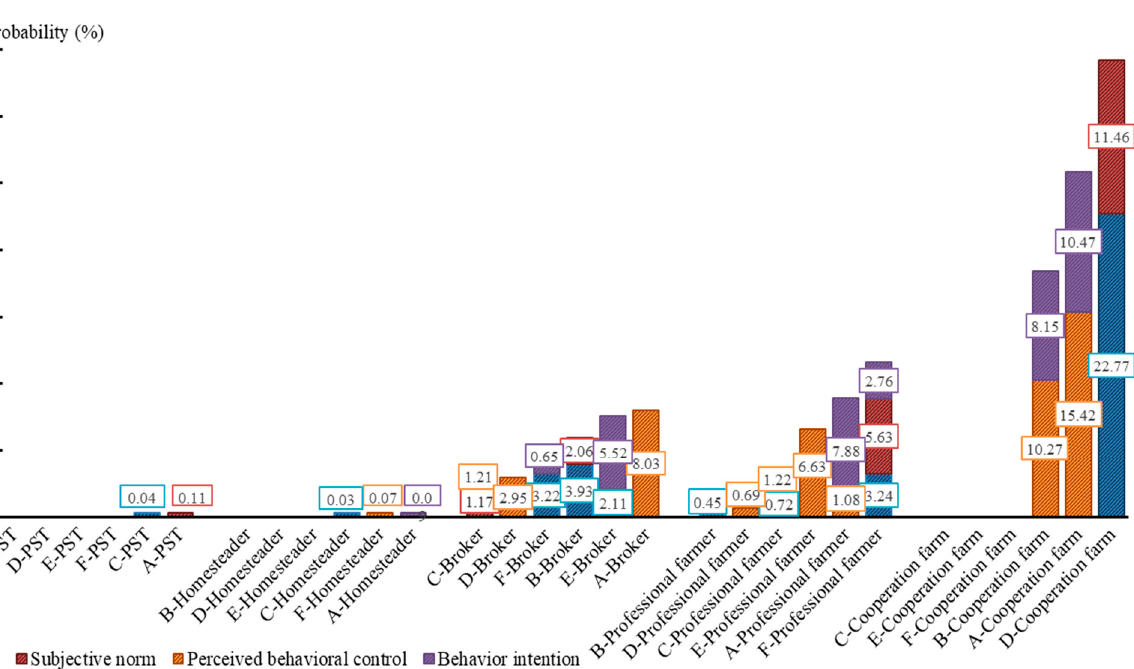
Figure 3. The effect comparison of each factor in the TPB for different potential farmer statuses for different contract types. Note: “A” designates the contract type of “Purchase-1”, “B” of “Purchase-2”, “C” of “Ordinary purchase-1”, “D” of “Ordinary purchase-2”, “E” of “Ordinary purchase-3”, and “F” is the “Adjustment for bullish market”.